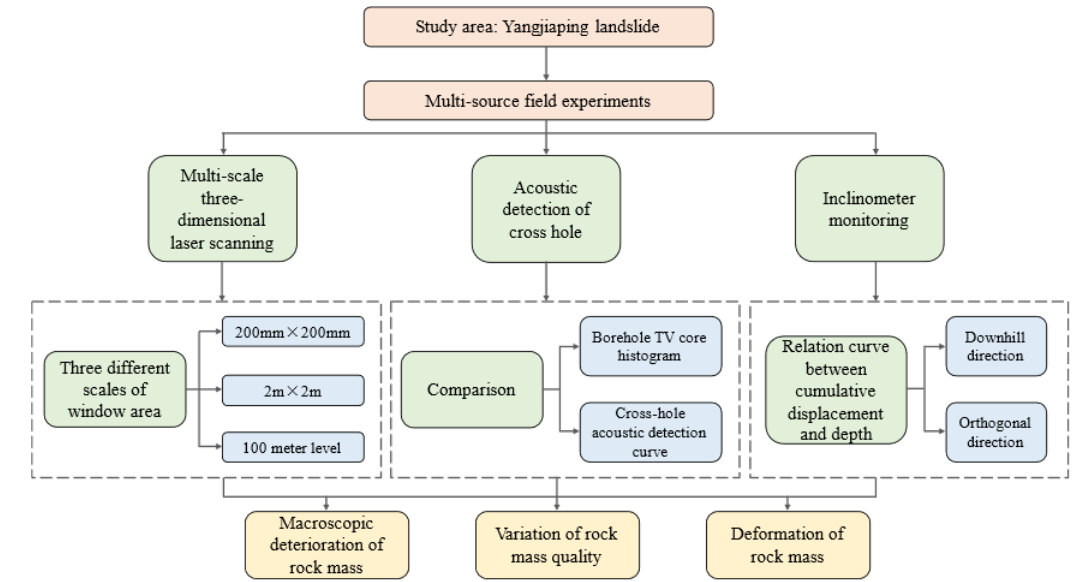
Figure 1. The degradation analysis methods of the typical reverse sand–mudstone interbedded bank slope based on multi-source field experiments.